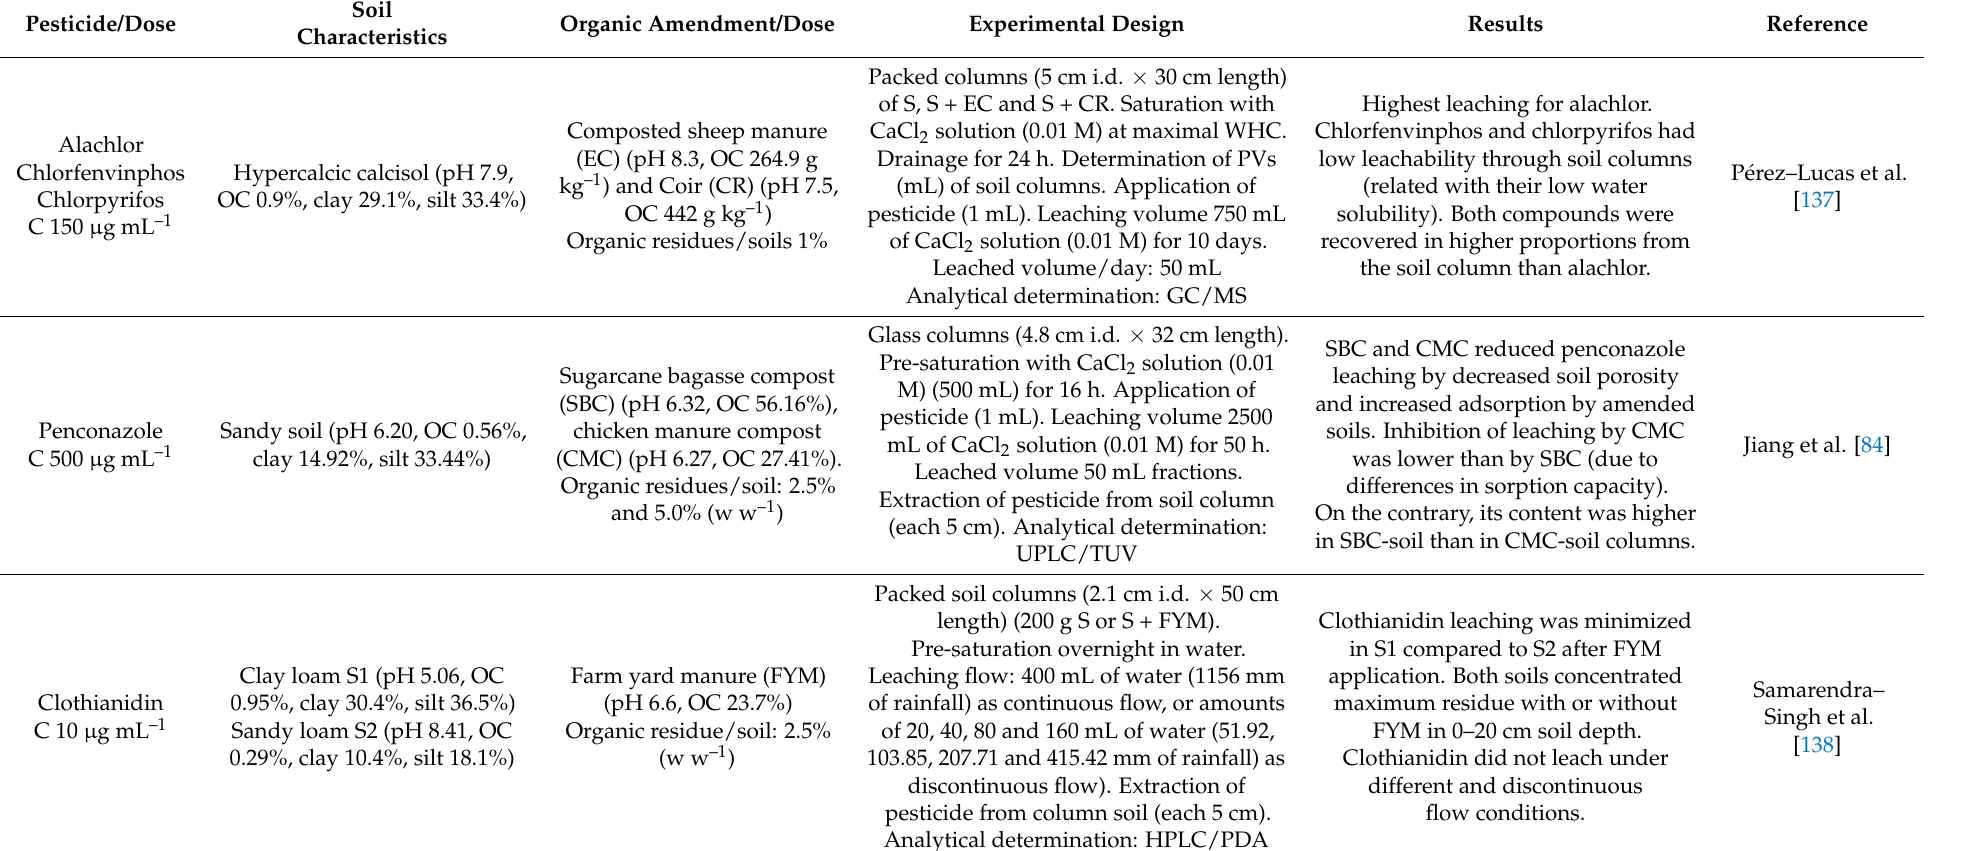
Table 2. Leaching of pesticides in amended